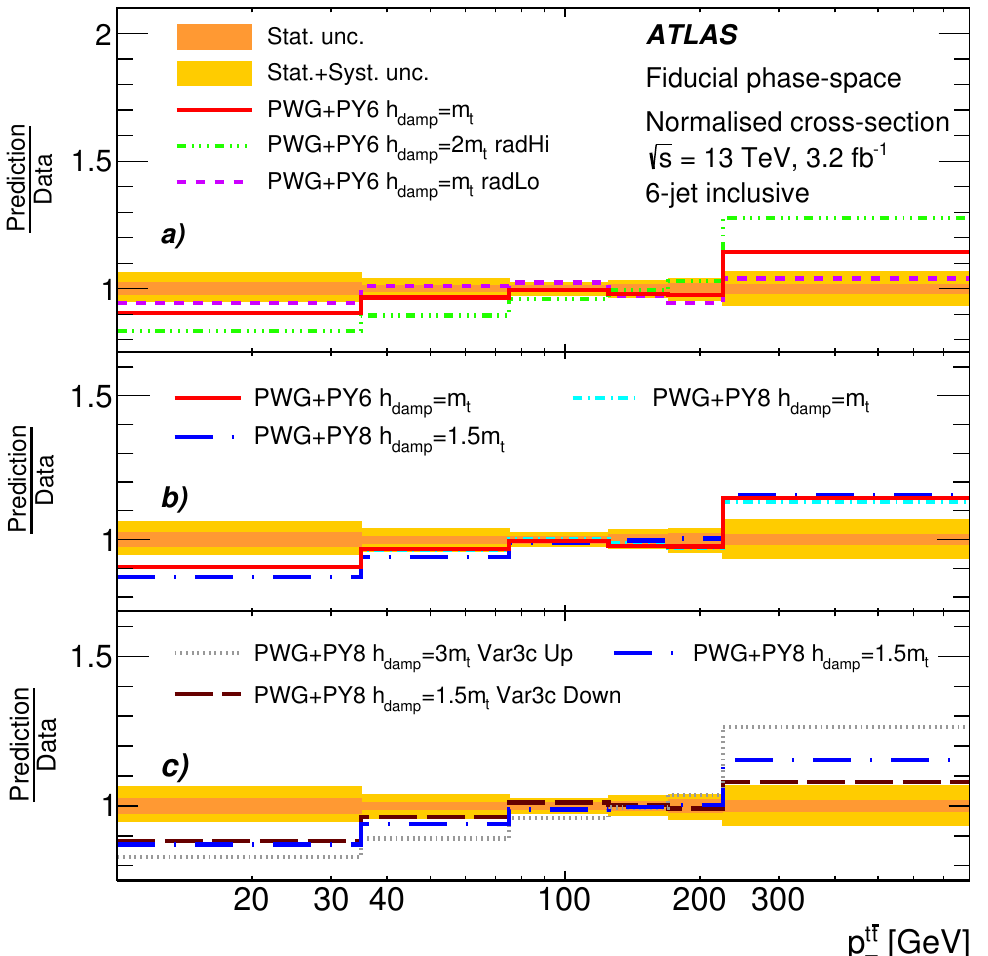
Figure 11 . Normalised di(cid:11)erential cross sections as a function of p t (cid:22) t ration in the (cid:12)ducial phase space. The dark shaded area is the statistical uncertainty and the light shaded area represents the total